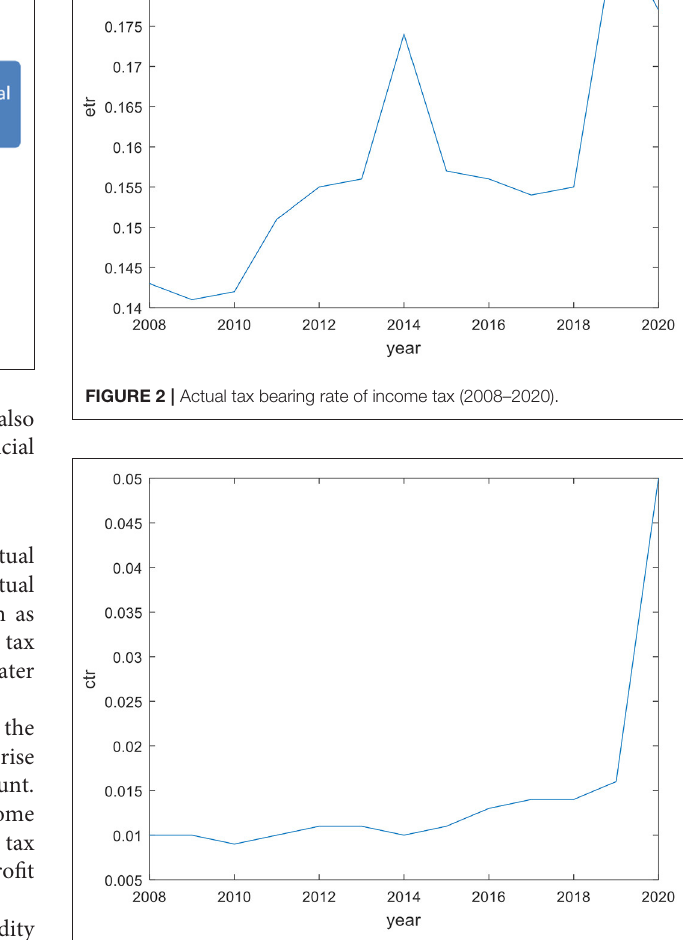
FIGURE 3 | Actual tax bearing rate of commodity turnover tax